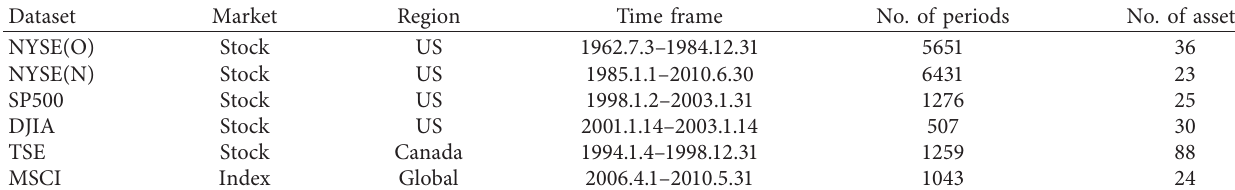
Table 2: Summary of the six datasets from real